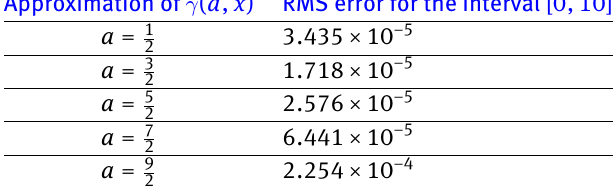
Table 1: RMS error for every approximation of incomplete Gamma